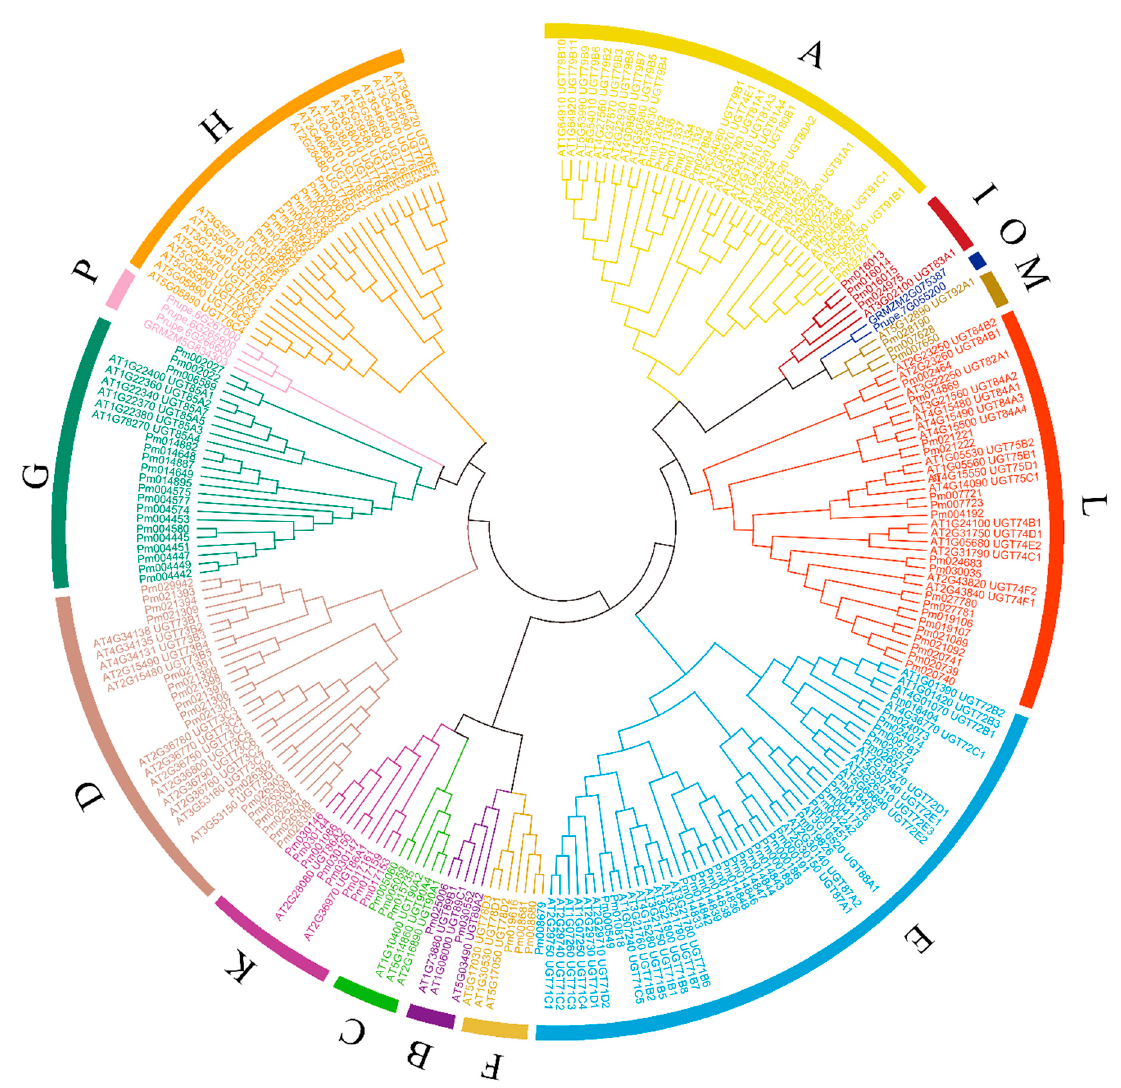
Figure 3. Phylogenetic tree of the plant UGTs. 130 PmUGTs, 112 A. thaliana UGTs, 2 maize UGTs (GRMZM2G075387 and GRMZM5G834303) and 4 peach UGTs (Prupe.7G055200, Prupe.6G265900, Prupe.6G267000 and Prupe.6G266600) were included. The full-length sequences of the UTG proteins were aligned using CLUSTALW and the phylogenetic tree was constructed using the ML method in the MEGA 6.0 [37]. The colored lines mark the groups of the UGTs.